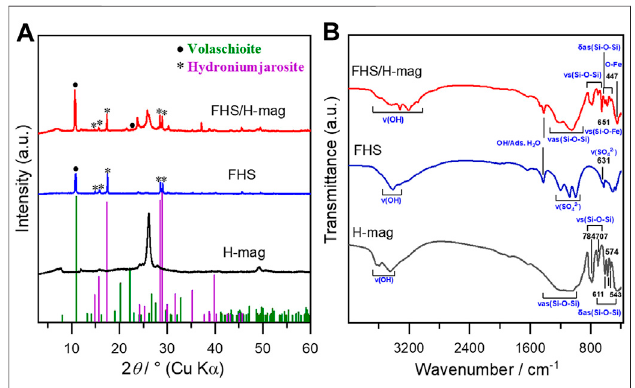
FIGURE 1 | (A) XRD patterns and (B) FT-IR spectra of H-mag, FHS and FHS/H-mag